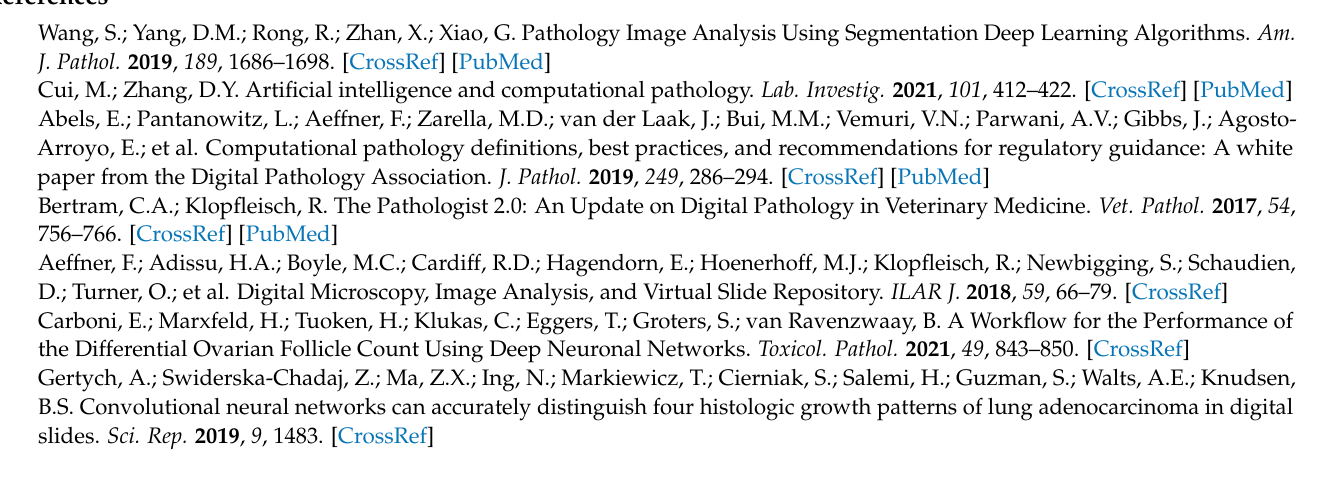
Material Figure S1. Training loss during model establish-ment. Supplementary Material Figure S2. Discrepancy in inflammation detection between annota-tion and algorithm prediction. Supplemen- tary Material Figure S3. Comparison of portal triad de-tection between 3 class model and 4 class model. Supplementary Material Figure S4. Discrepancy in connective tissue detection between annotation and algorithm